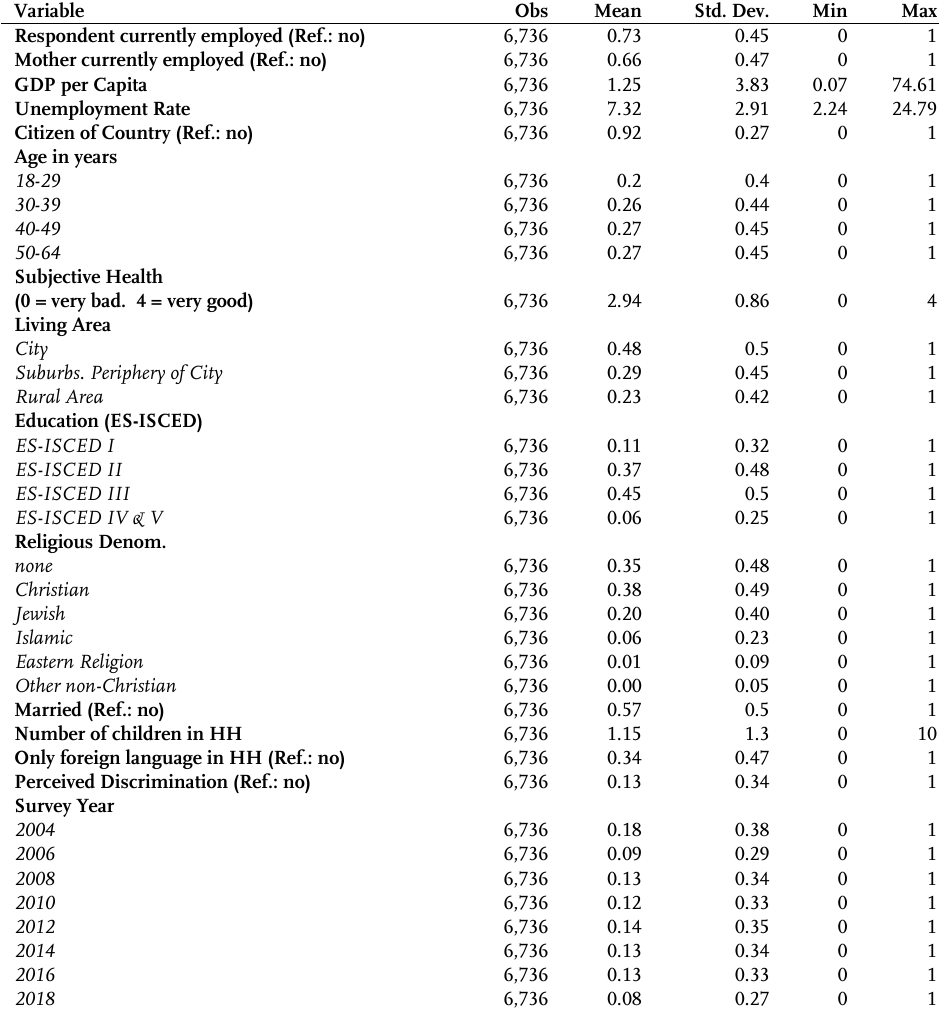
Table A.2 : Descriptive statistics female descendants of